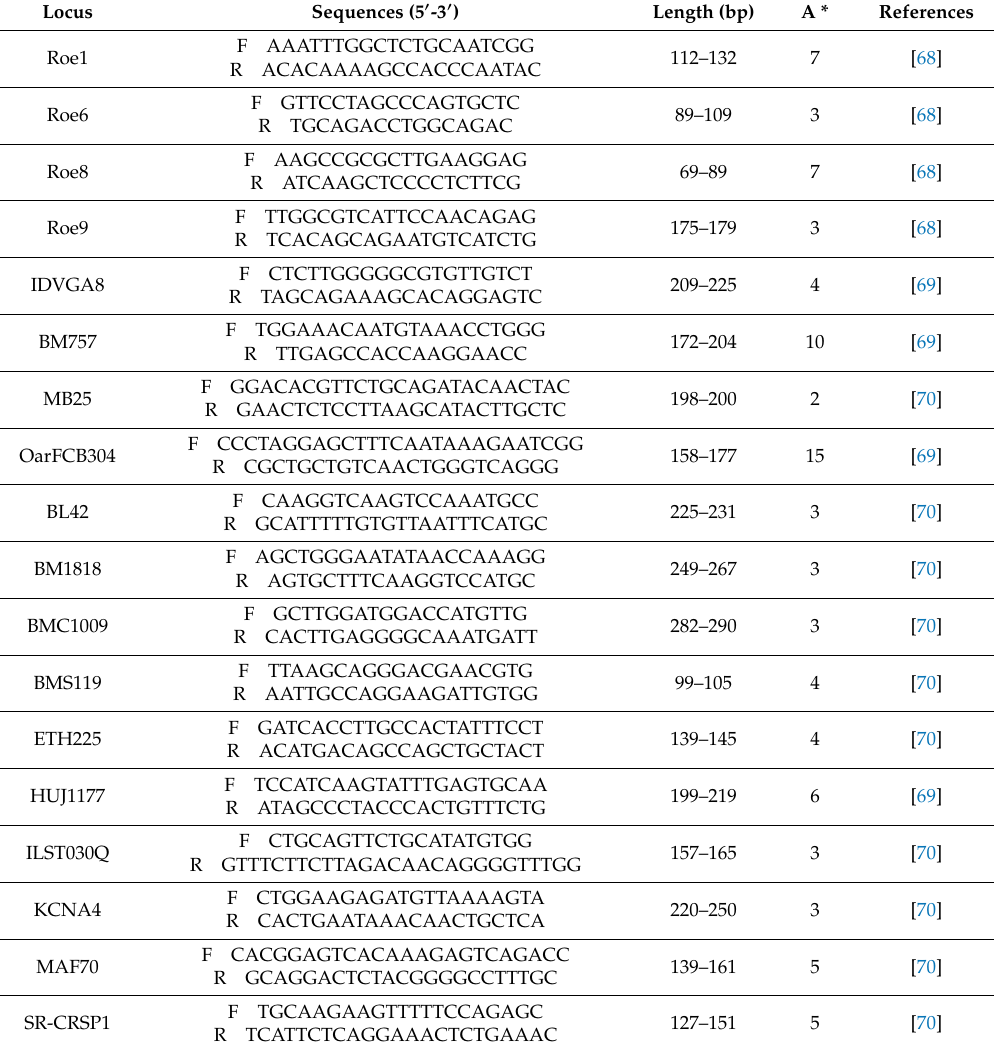
Table A1. Candidate loci used in identifying Siberian roe deer ( Capreolus pygargus ) individuals using fecal DNA to estimate population abundance in Liangshui National Nature Reserve in the Lesser Xing’an Mountains, China, in